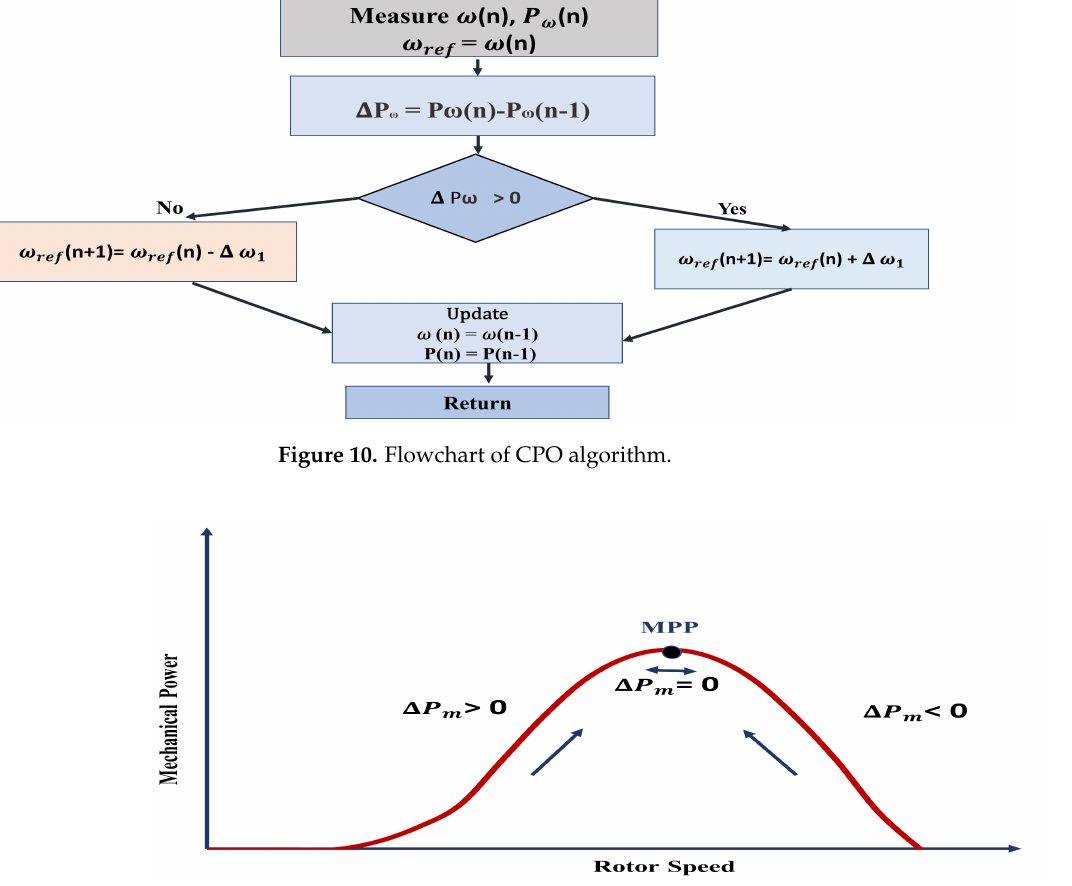
Figure 11. Concept of working of CPO MPPT algorithm. Reused with permission from ref. [3]. Copyright 2021 Elsevier.